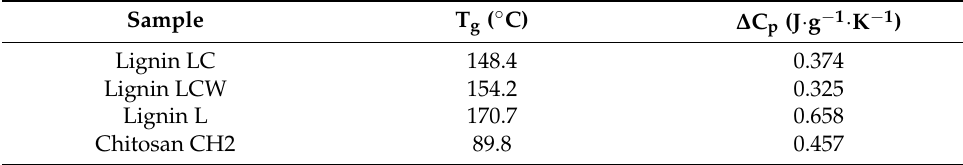
for Lignin L. Table 2. Glass transition temperatures and their associated change in heat